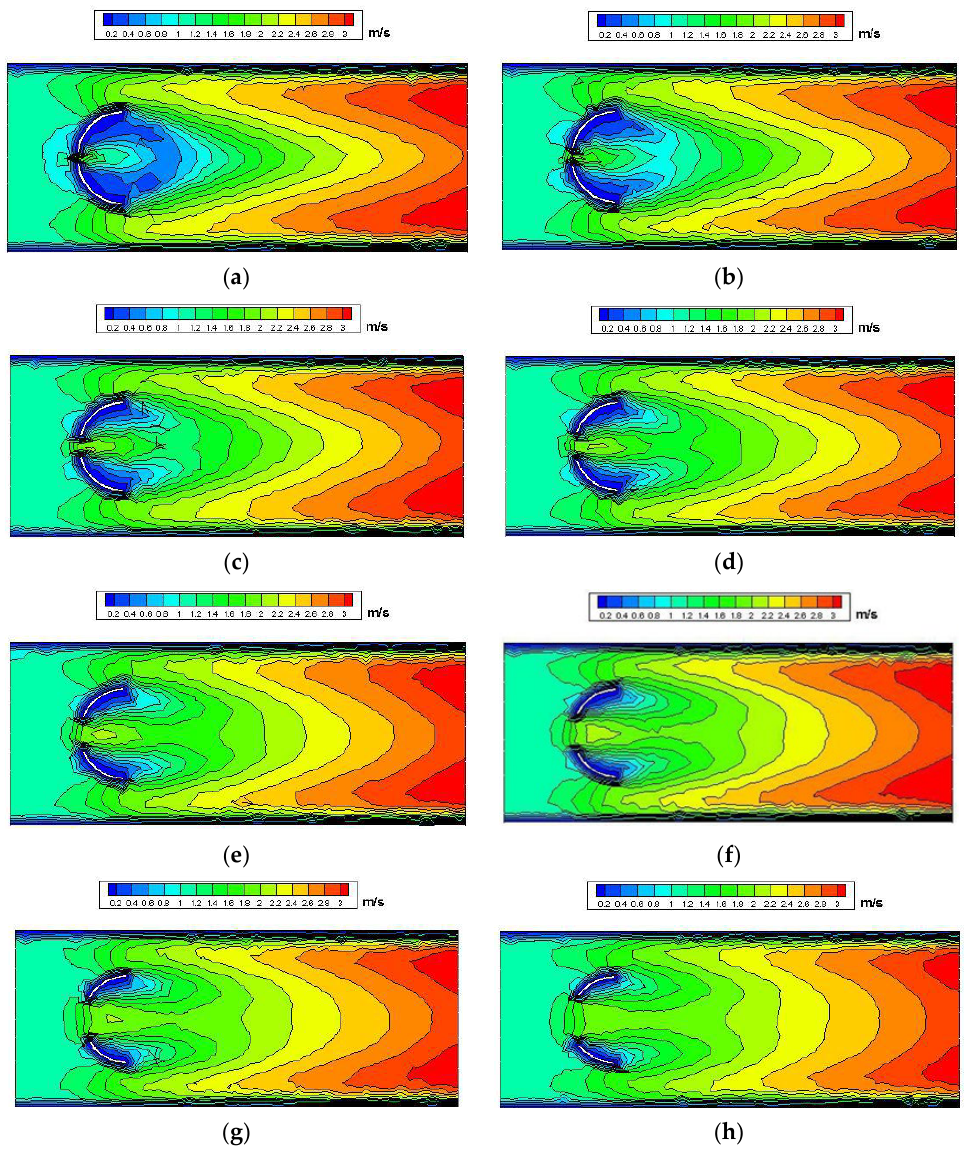
Figure 6. ( a – h ) Velocity field at different slot width ratios (v = 1.0 m/s).